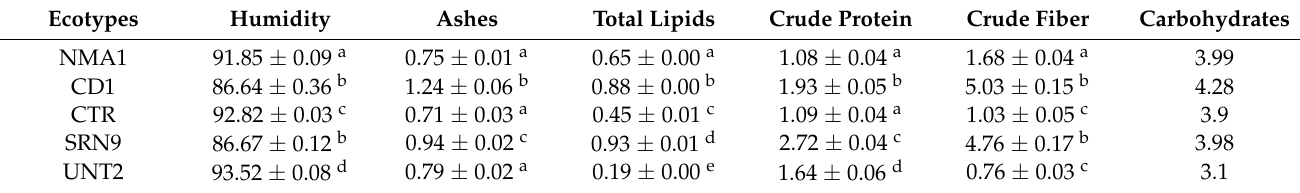
Table 1. Proximal composition of cocona fruits NMA1, SRN9, CD1, CTR, UNT2 ecotypes. Ecotypes